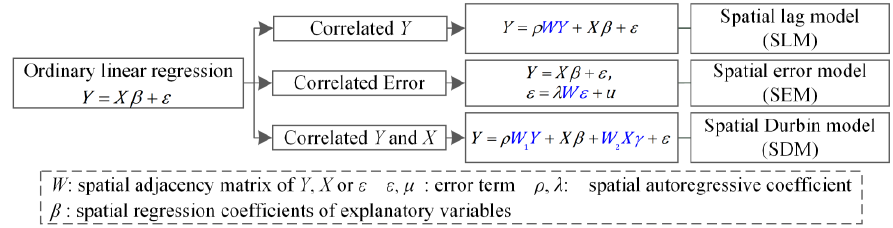
Figure 13. Spatial regression models.